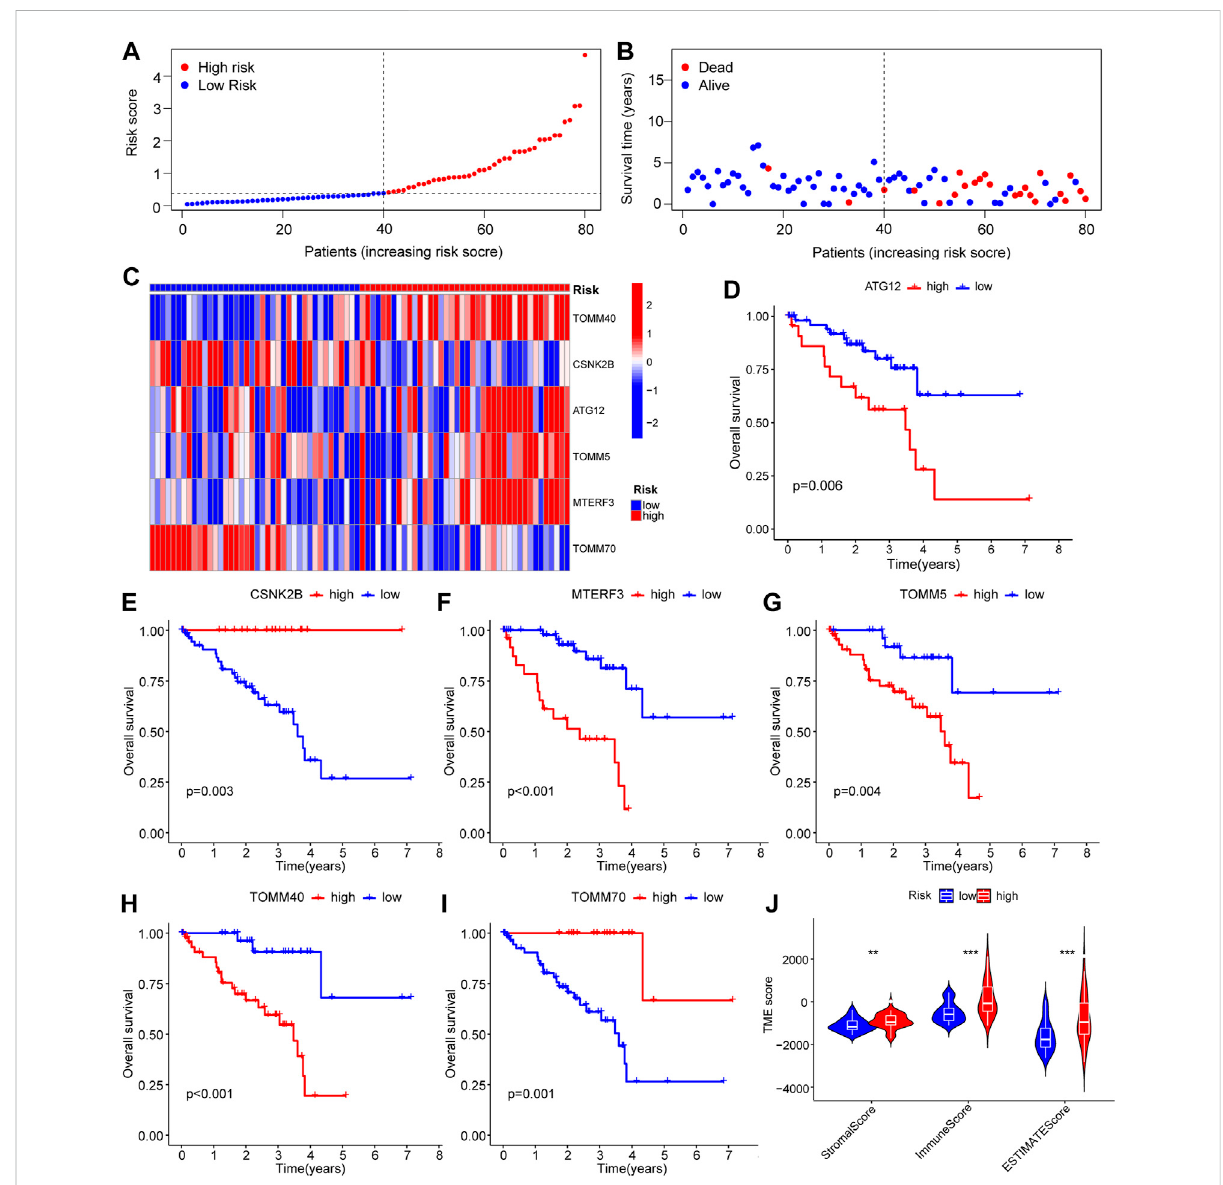
FIGURE 5 Survival-relatedanalysisbasedontheprognosticmodelofmitophagy-relatedgenes. (A – C) Riskscoreofpatientsamplesbetweenhighandlow RiskscoregroupsinLASSOmodel (A) andexpressionofsurvivalstatusofpatientsbetweenhighandlowriskgroups (B) andcomplexheatmapresults ofprognosticgenesinthemodel (C) . (D – I) KMcurvesforsurvivalanalysisofmitophagy-relatedgenes,includingATG12 (D) , CSNK2B (E) , MTERF3 (F) , TOMM5 (G) , TOMM40 (H) and TOMM70 (I) in the LASSO model. (J) Estimate analysis results between high and low Riskscore groups of the LASSOmodelshowthegroupcomparisonofStromalScore,ImmuneScore,andESTIMATEScore.Ns,notsigni fi cant;*, p < 0.05;**, p < 0.01;***, p < 0.001. LASSO, least absolute shrinkage and selection operator; KM, Kaplan –